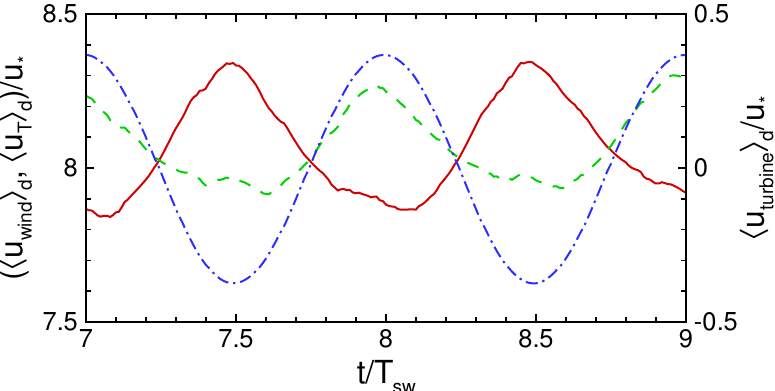
Figure 10. Time series of turbine-rotor-disk averaged velocity components for the floating-turbine case. Here, (cid:104) u wind (cid:105) d is the averaged incoming wind velocity (dashed line), (cid:104) u turbine (cid:105) d is the turbine rotor velocity caused by the swell-induced pitch motion (dash-dot line), and (cid:104) u T (cid:105) d = (cid:104) u wind (cid:105) d − (cid:104) u turbine (cid:105) d (solid line). Values for (cid:104) u T (cid:105) d and (cid:104) u wind (cid:105) d are shown on the vertical axis plotted on the left side (ranging from 7.5 to 8.5, and values for (cid:104) u turbine (cid:105) d are shown on the vertical axis plotted on the right side (ranging from − 0.5 to